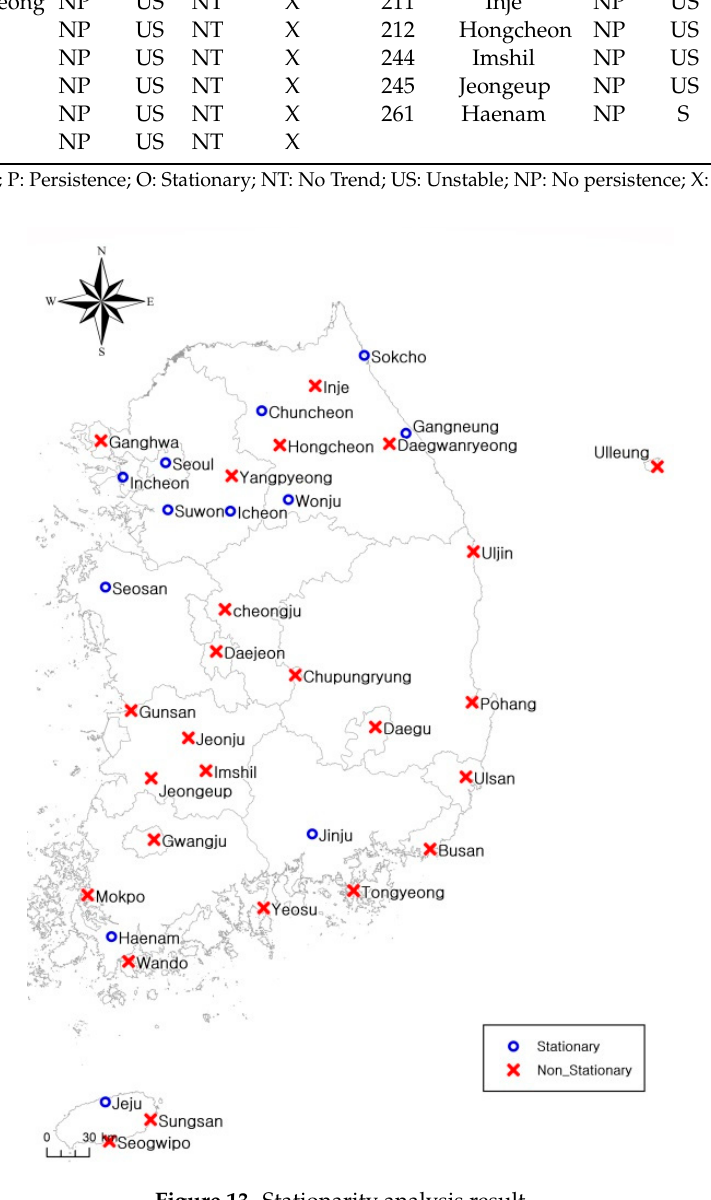
Figure 13. Stationarity analysis result.